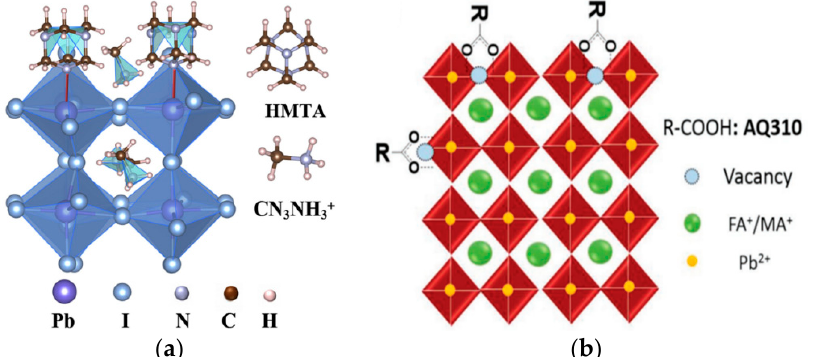
Figure 5. Crystal structure of perovskite passivated by ( a ) hexamethylenetetramine (HMTA) [46] and ( b ) AQ310 [48]. Table 2. Summary of research about improving the PCE of PSC by passivating grain boundaries (GBs). Additive Device